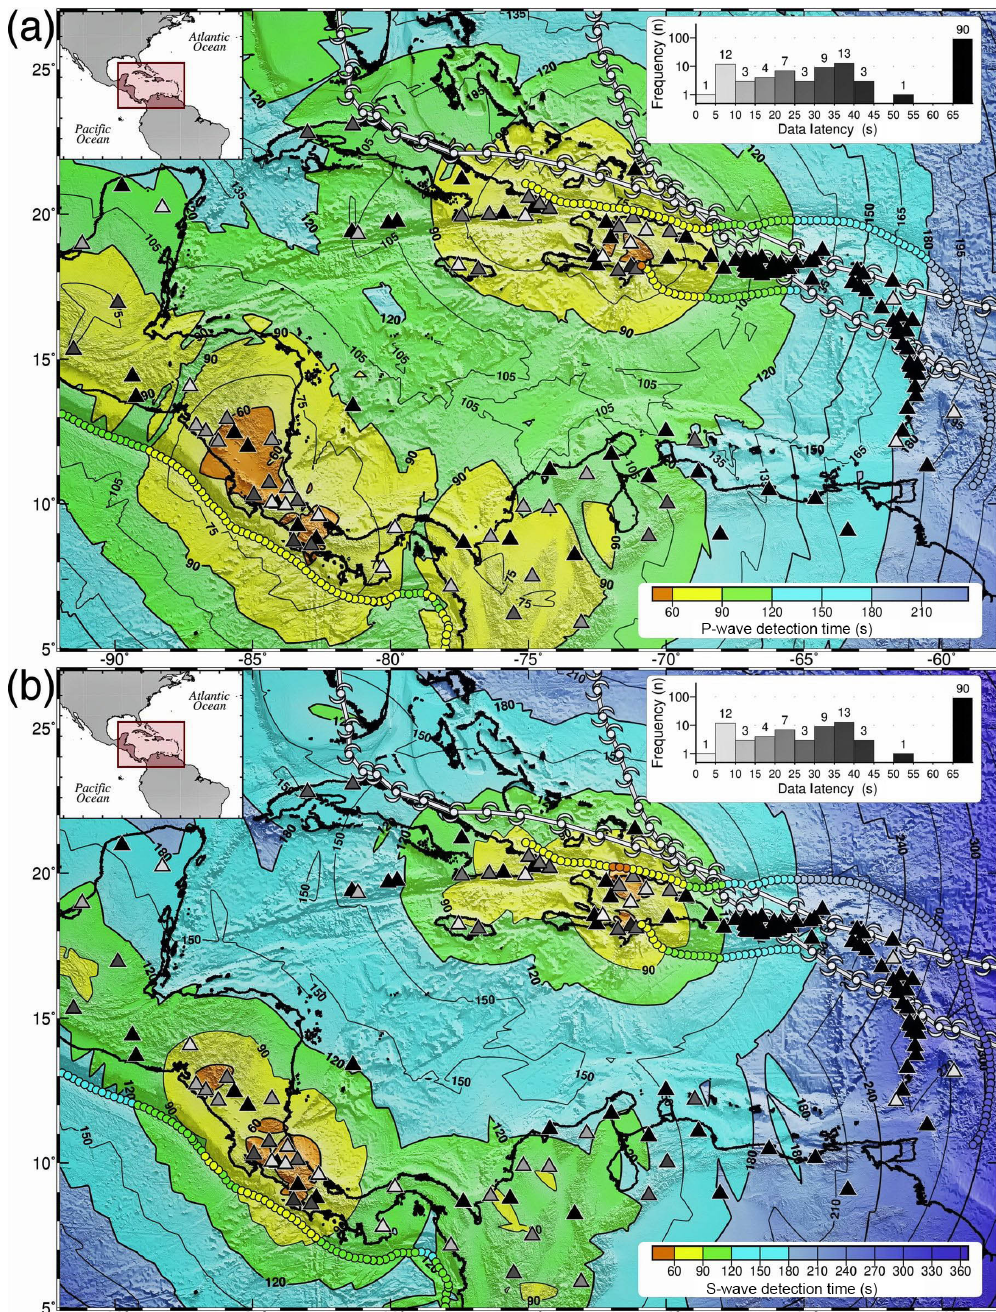
Figure 6. Theoretical detection time of the first arriving P and S waves in the Caribbean after hurricane Maria on 23 September 2017. The 37 additional station outages attributed to Hurricane Maria now add up to 61% (90 black triangles) of the 146 stations. These unprecedented station outages further reduced the 90 (yellow) and 60s (orange) detection areas to 24.3% and 1.35% of the region for P wave detection, and (b) 8.5% and 0.9% of the total area for S wave detection. The 30s detection area disappears in both (a) and (b) . The small, contiguous circles show the computed P and S wave detection times sampled every 25km along the trench axes. White vortex tracks show the path of hurricanes Irma to the north and Maria to the